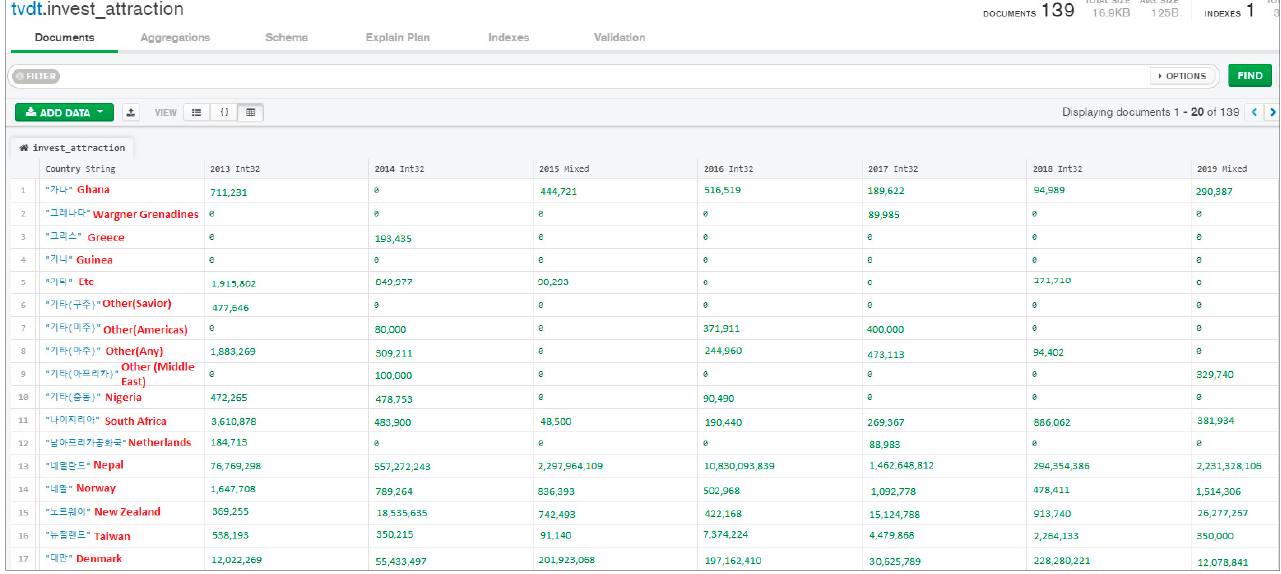
Figure 21. Metadata of Invest attraction data.